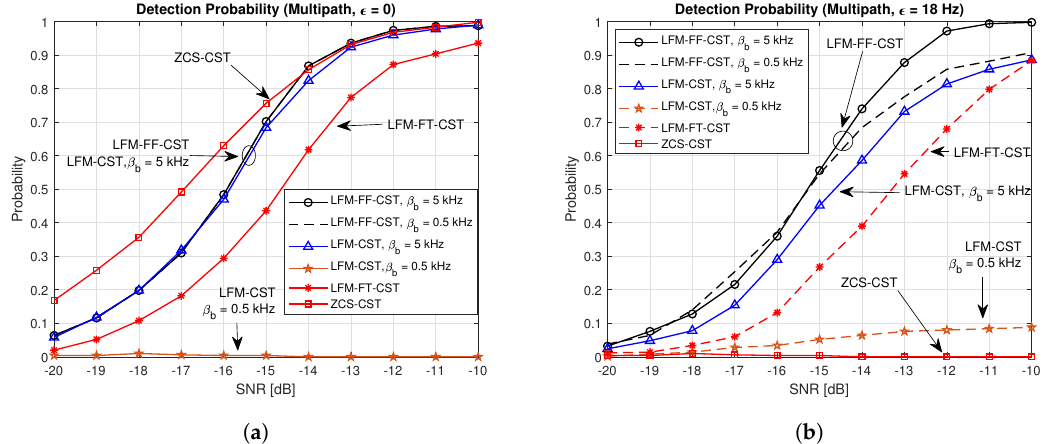
Figure 10. Detection probabilities of proposed and conventional techniques in multipath channel. ( a ) Multipath channel, (cid:101) = 0 Hz; ( b ) Multipath channel, (cid:101) = 18